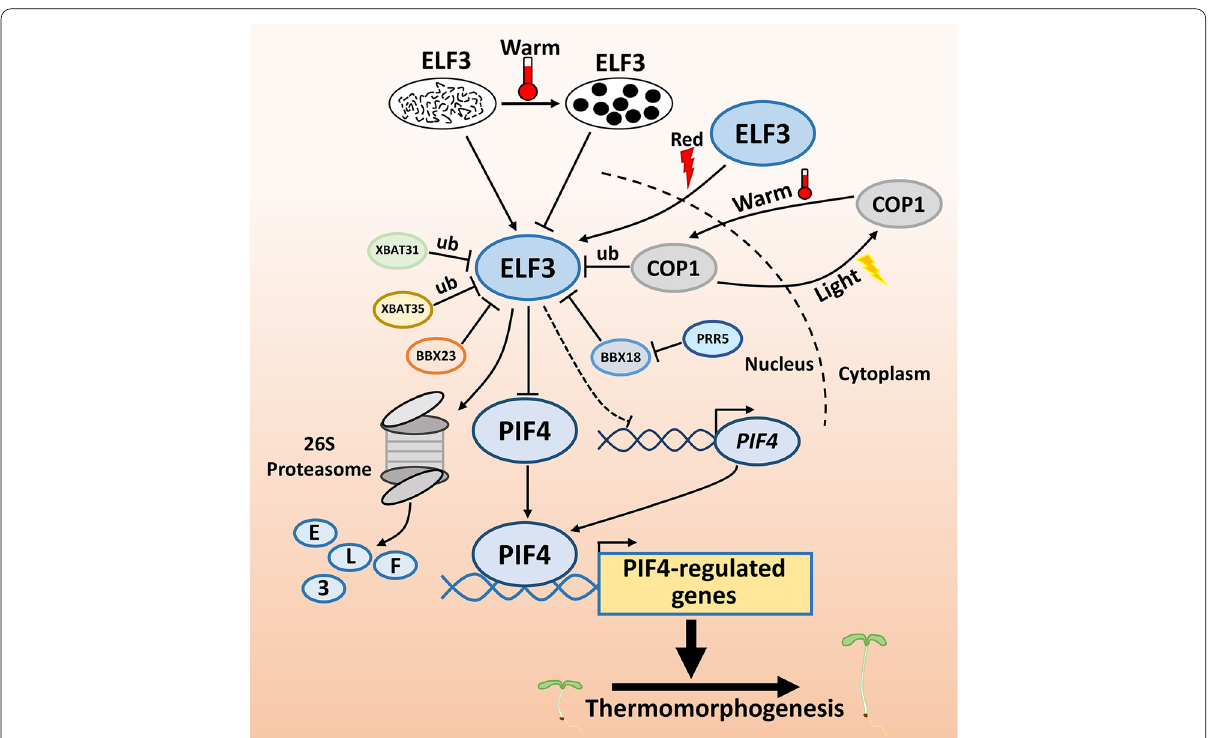
Fig. 3 ELF3-PIF4-mediated thermomorphogenic response. Warm temperatures induce the ELF3 to form liquid droplets, thereby releasing the inhibition of PIF4 action. XBAT31 and XBAT35 target the ELF3 for ubiquitination and subsequent degradation. BBX18 and BBX23 facilitate the ELF3 degradation by recruiting ELF3 to XBAT31 and XBAT35. PIF4 regulates the expression of downstream target genes to promote thermomorphogenesis. ub represents